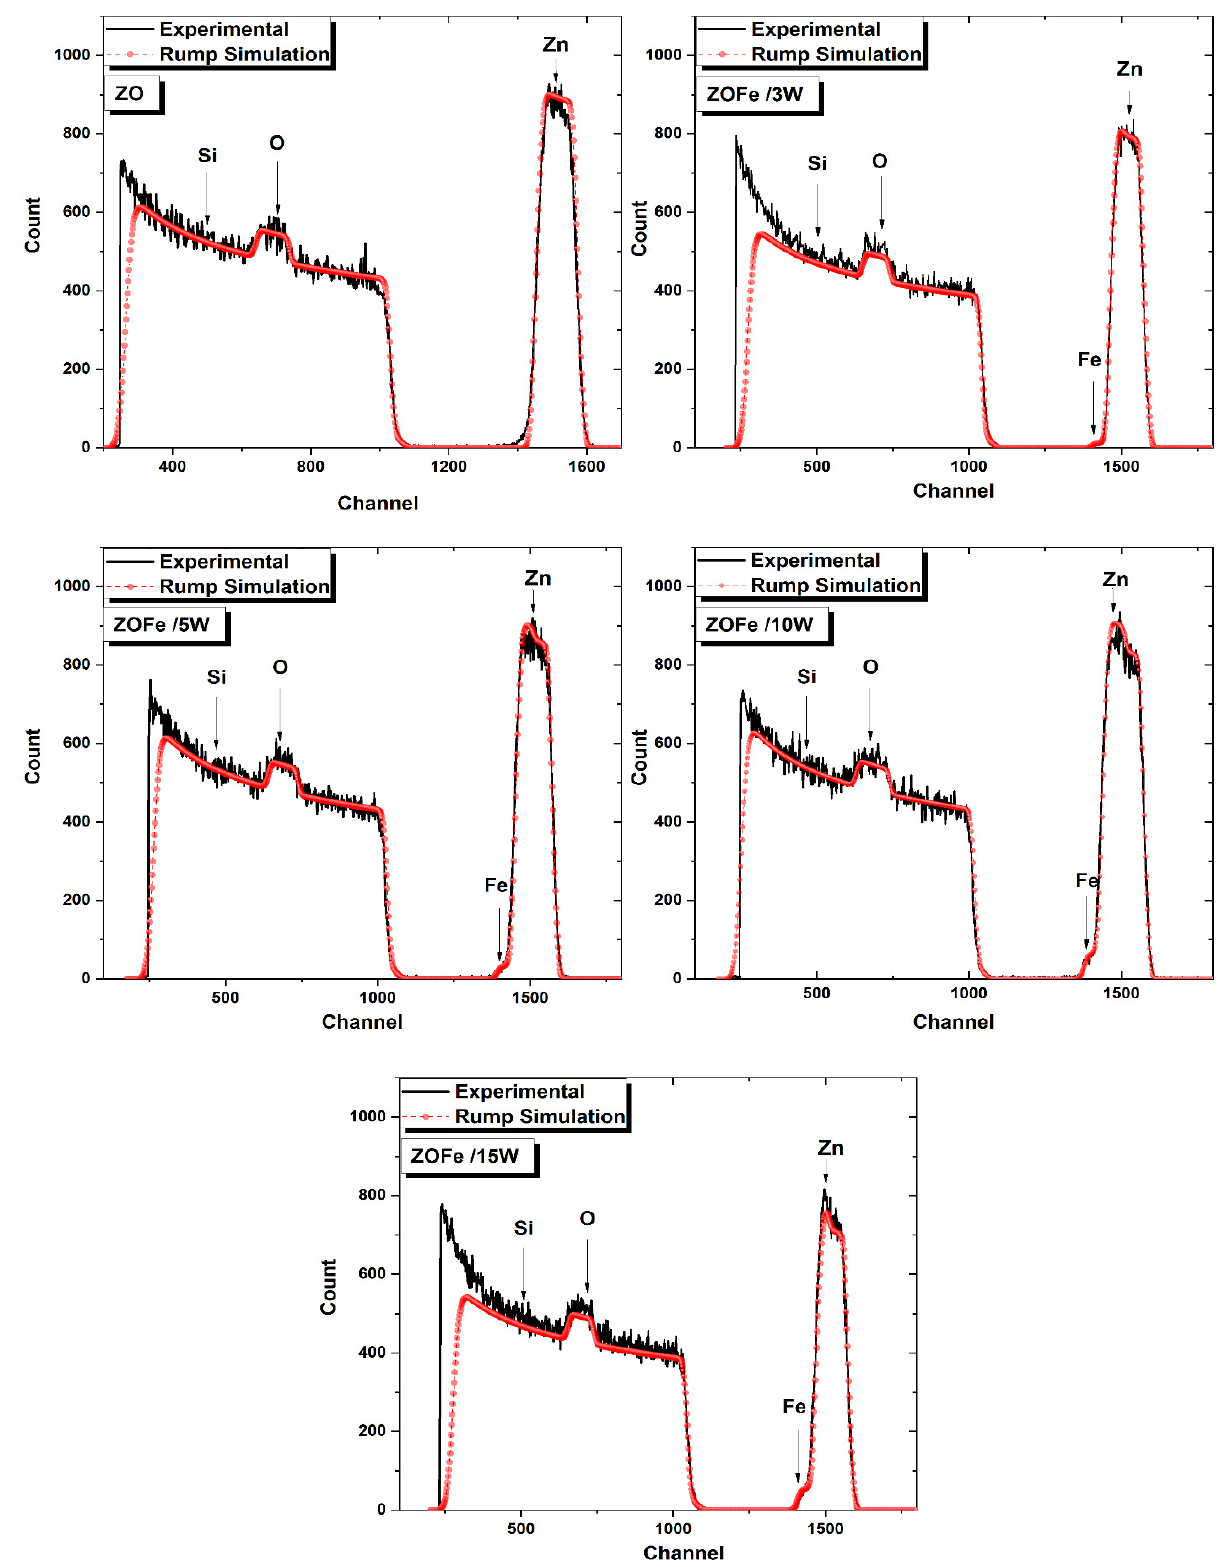
Figure 1. RBS random spectra for the ZO and ZOFe thin films deposited on Si. One can notice that the surface edge for the different elements (Zn, O, Si and Fe) can be observed clearly from Figure 1. The large peak on the right-hand side located in